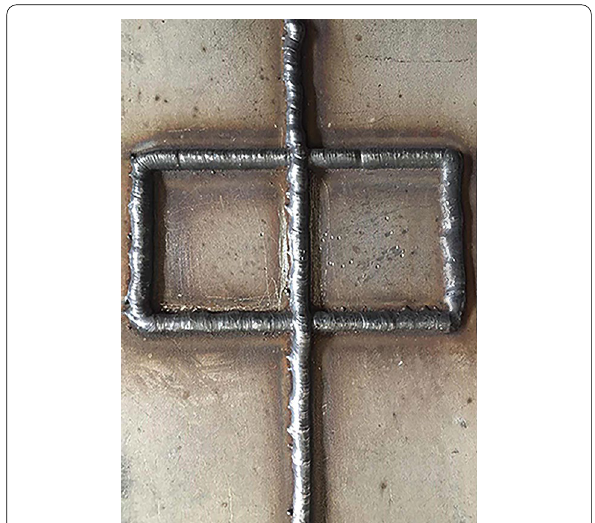
Figure 17 Metal part in form of Chinese character by self-adaptive DE-MPAW control system